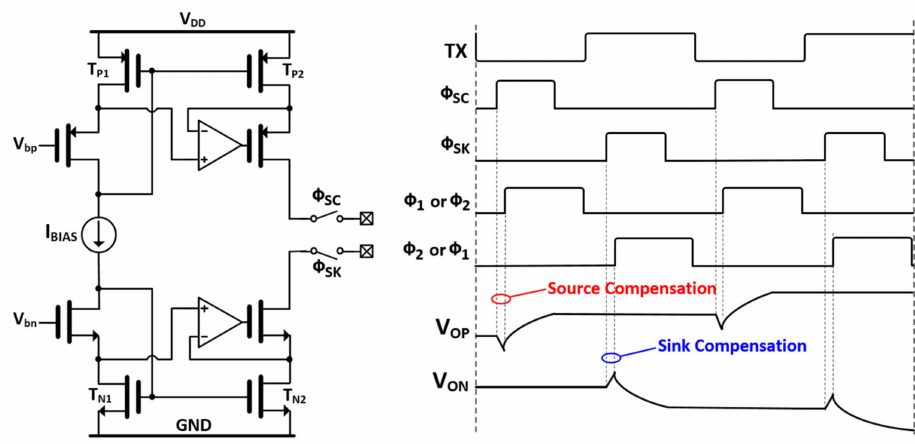
Figure 8. Circuit implementation of a capacitance compensator and its timing